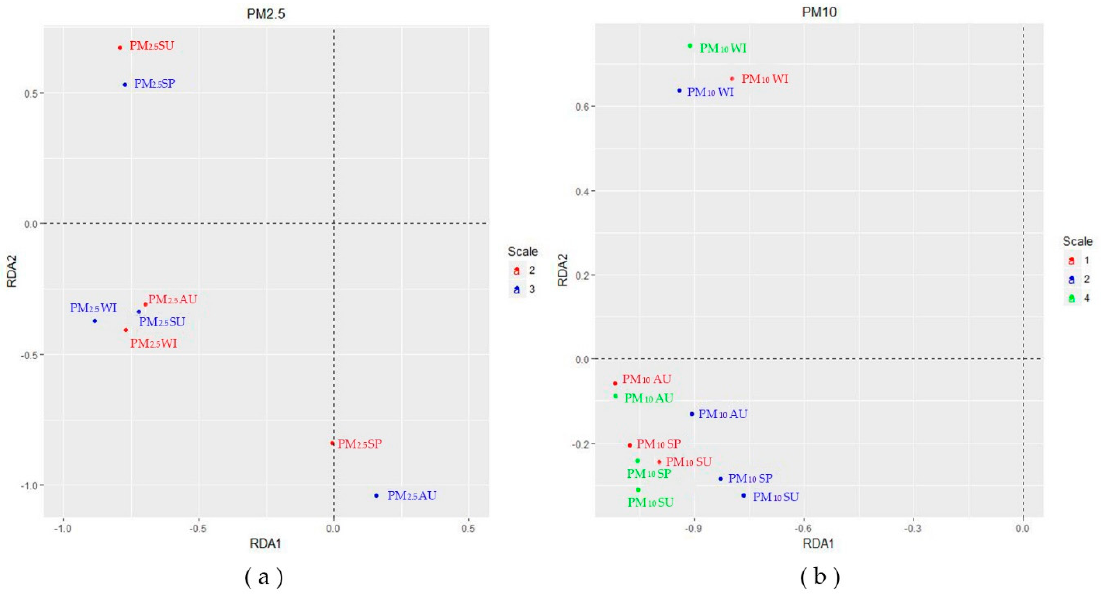
Figure 4. Scores of seasonal PM 2.5 and PM 10 concentration at the first two RDA axes. ( a ) Seasonal PM 2.5 concentration scores at the first two RDA axes; ( b ) seasonal PM 10 concentration scores at the first two RDA axes.